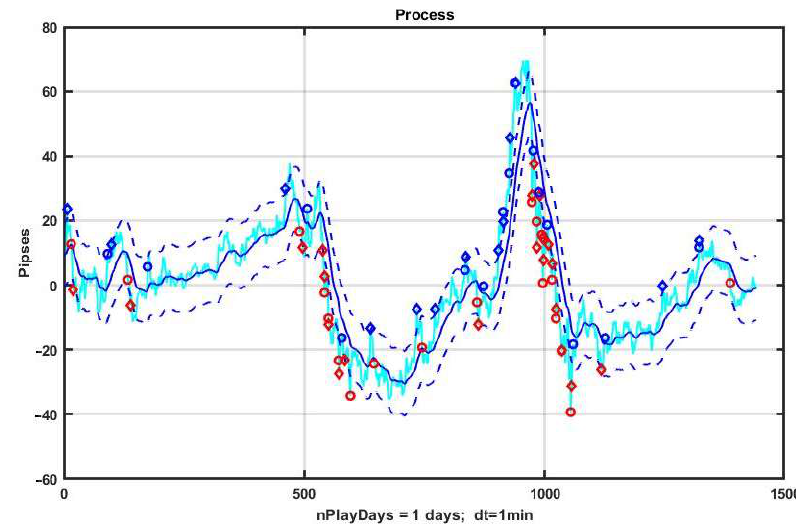
Figure 1. Example of CSF implementation.